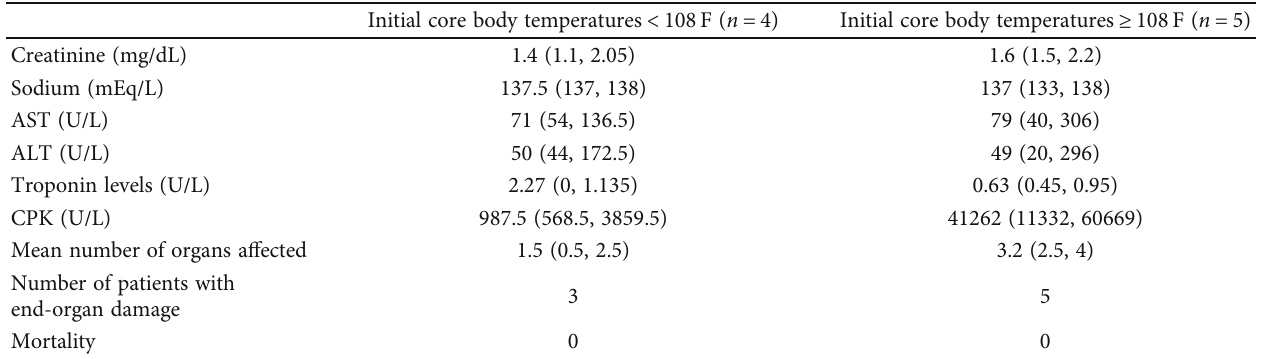
Table 2: Comparison of variables between the initial core body temperature groups ( < 108F vs. ≥